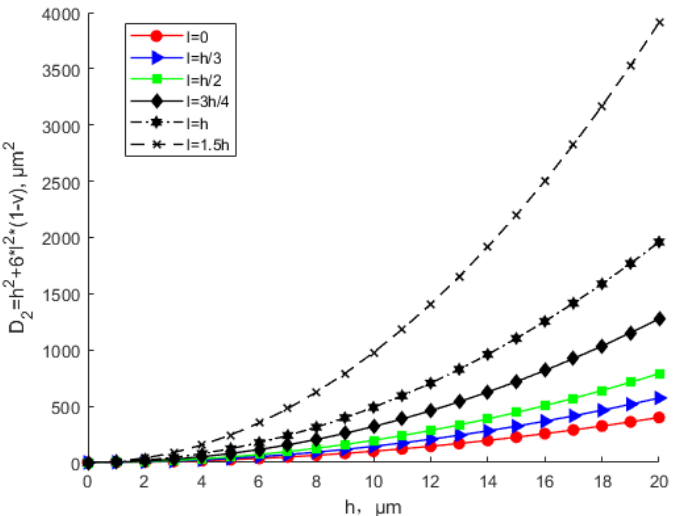
Figure 4. Effects of the scale parameter about h on equivalent bending stiffness based on CT and MCST.